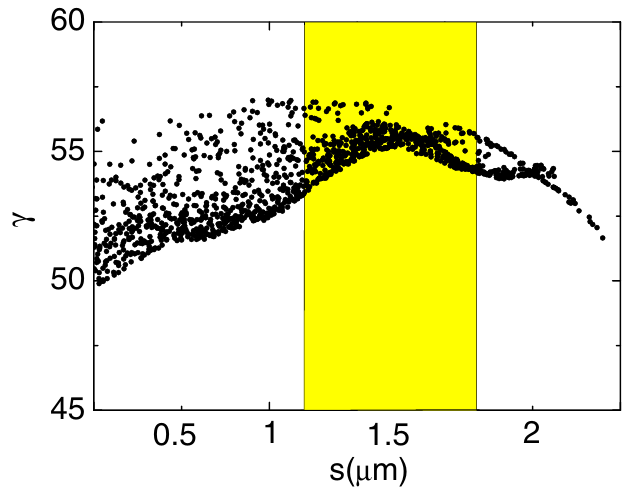
FIG. 6. (Color) Longitudinal phase space (cid:3) vs s (cid:1) (cid:4) m (cid:2) .